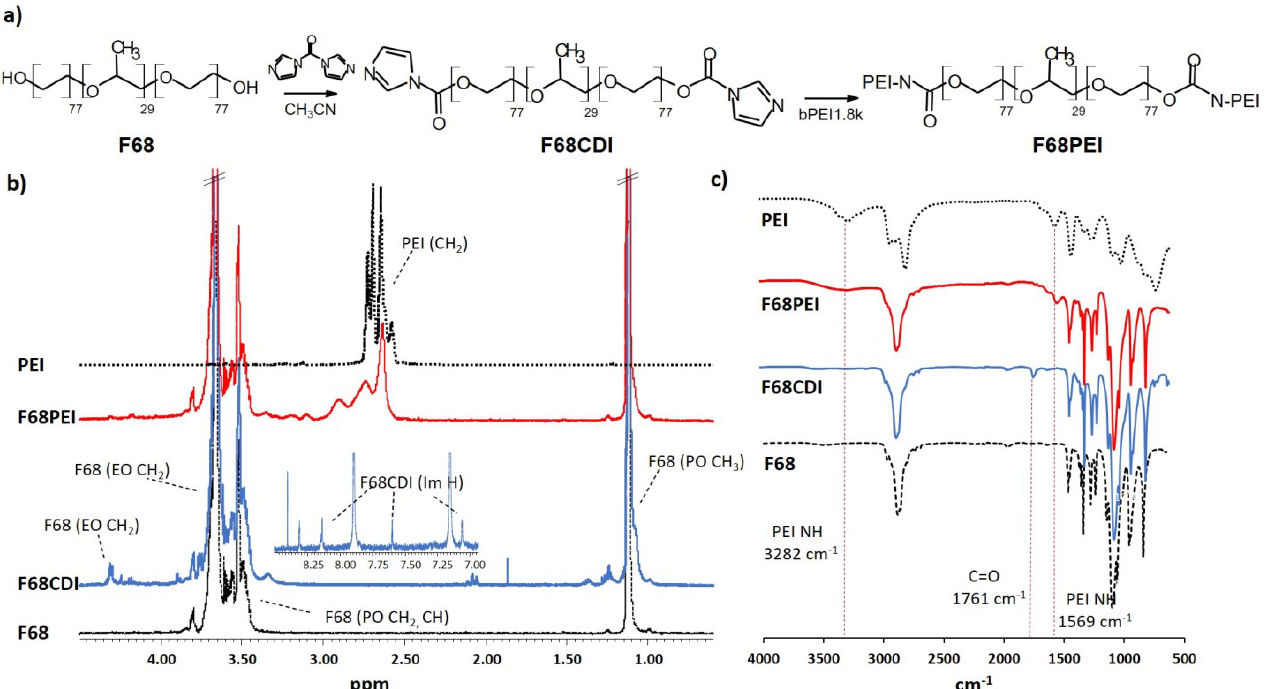
Figure 1. Synthesis and characterization of F68PEI copolymer. ( a ) Synthesis scheme; ( b ) 1 H NMR spectra of F68, PEI, intermediary F68CDI and copolymer F68PEI. Insert shows the aromatic region with imidazole multiplets. Some multiplet resonances are assigned; ( c ) IR spectra of F68, PEI, intermediary F68CDI and copolymer F68PEI. Vertical lines indicate the appearance of characteristic peaks of new functional groups during F68PEI synthesis: introduction of a carboxylic group in F68CDI (1761 cm −1 ) and the appearance of vibrations characteristic of PEI in F68PEI (1569 and 3282 cm −1 ).